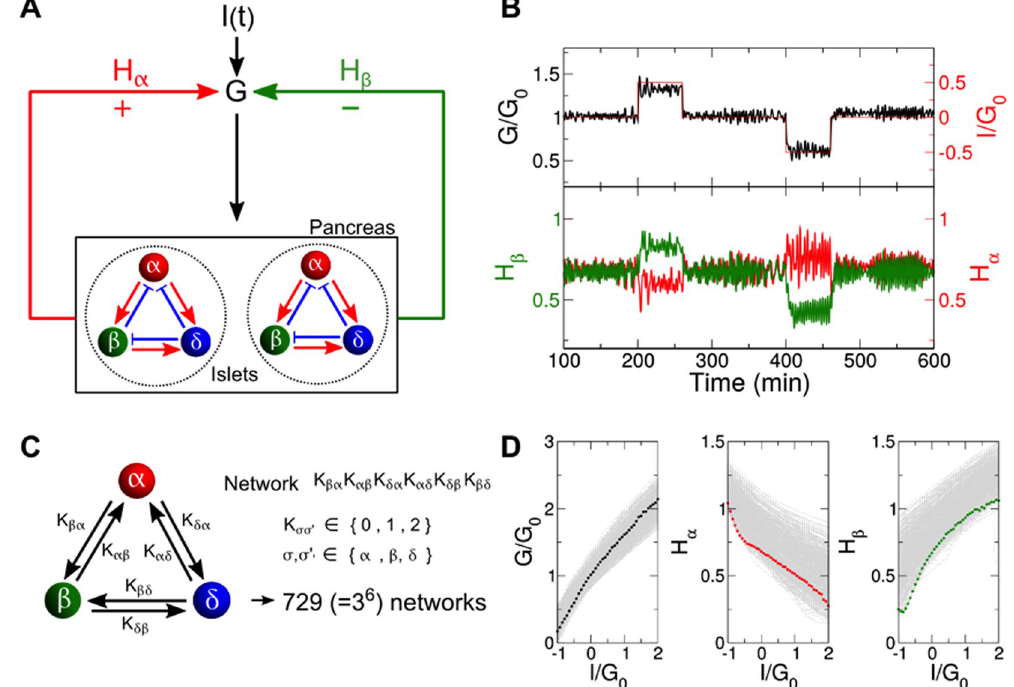
Figure 1. Glucose regulation and islet cell network. ( A ) Schematic diagram of glucose regulation by pancreatic islets. Endocrine α , β , and δ cells in the pancreatic islets monitor and regulate blood glucose concentration, G , perturbed by external input, I . Glucagon, H α , secreted by α cells increases G , while insulin, H β , secreted by β cells decreases G . ( B ) Given the external glucose input, I ( t ) (red line in upper plot), glucose G (solid black line) is regulated by two counter-regulatory hormones: H α (red line in lower plot) and H β (green line). Note that G 0 is the normal glucose concentration in the absence of an input ( I = 0). Network 121212 is used. ( C ) Network annotation for describing the interactions between islet cells. The interaction signs of A βα , A αβ , A δα , A αδ , A δβ , and A βδ can take zero (0), positive (1), or negative (2) values. Following this notation, network 121212 represents the native network of islet cells. ( D ) Stationary glucose concentration and the corresponding hormone consumption for various external glucose inputs. Negative/positive inputs, I , induce low/high glucose conditions. A total of 729 networks were considered: network 121212 (black, red, green) and the other networks (gray). See Section 2 in the Supplementary Material for the details of the model and standard parameter